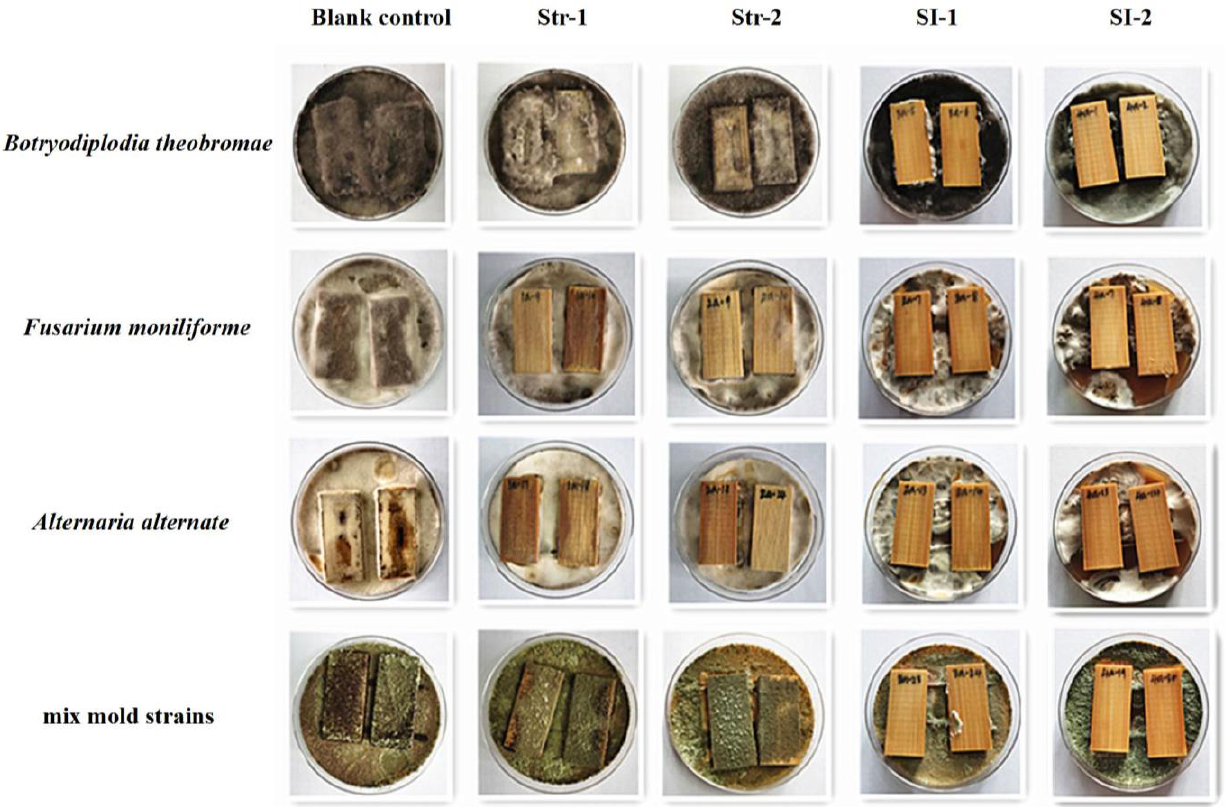
Figure 3. Treated bamboo specimens after mold and stain resistance tests. Table 4. Stain resistance of bamboo treated with selected chemicals.